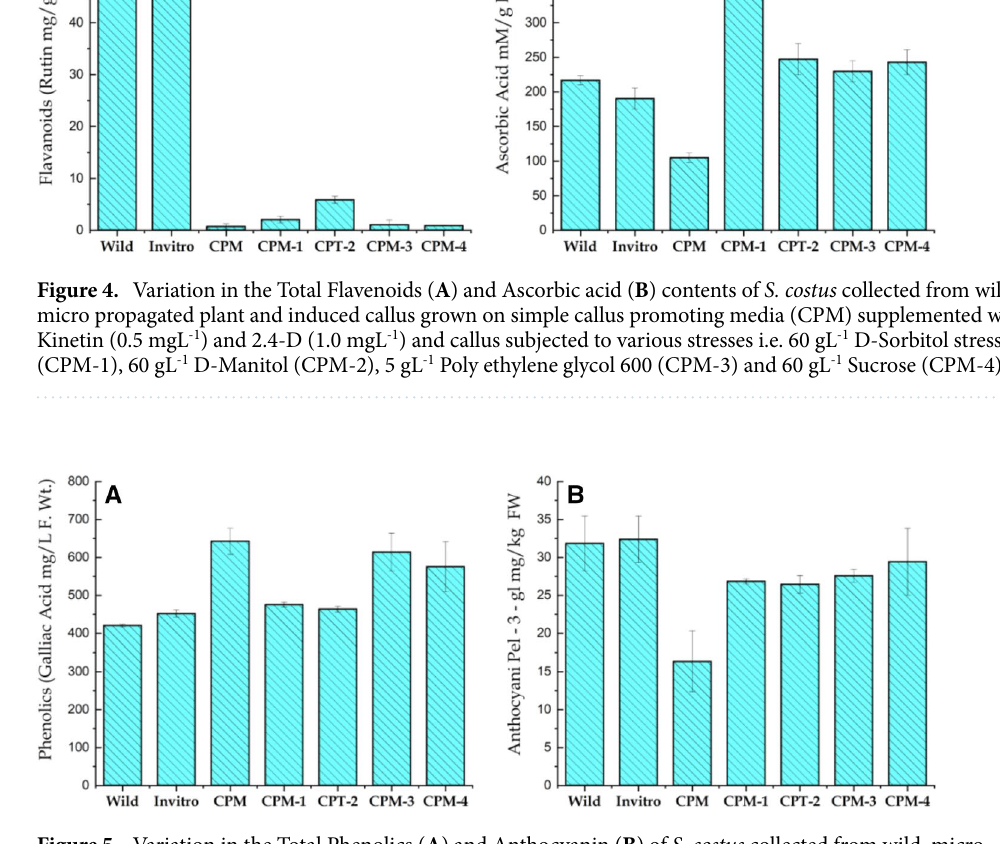
Figure 5. Variation in the Total Phenolics ( A ) and Anthocyanin ( B ) of S. costus collected from wild, micro propagated plant and induced callus. Different stresses for phytochemical comparison of callus grown on simple callus promoting media (CPM) supplemented with Kinetin (0.5 mgL -1 ) and 2.4-D (1.0 mgL -1 ) and callus subjected to various stresses i.e. 60 gL -1 D-Sorbitol stress (CPM-1), 60 gL -1 D-Manitol (CPM-2), 5 gL -1 Poly ethylene glycol 600 (CPM-3) and 60 gL -1 Sucrose